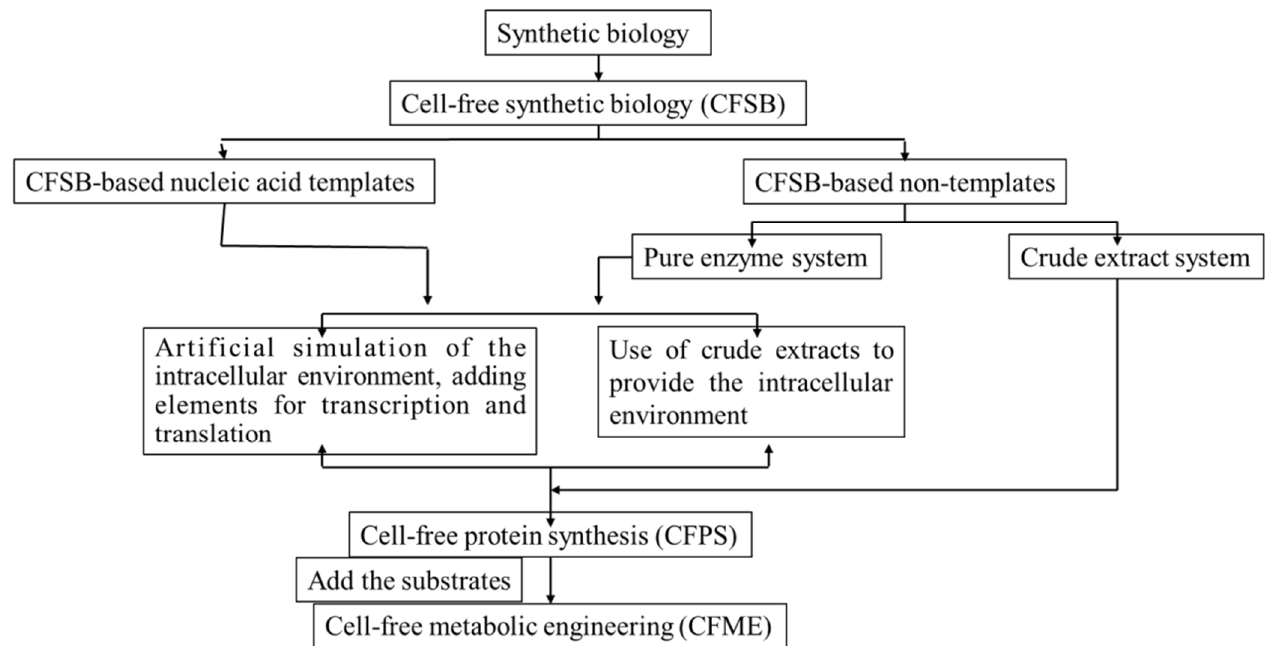
Figure 1. Cell-free systems based on nucleic acid templates and non-nucleic acid templates.